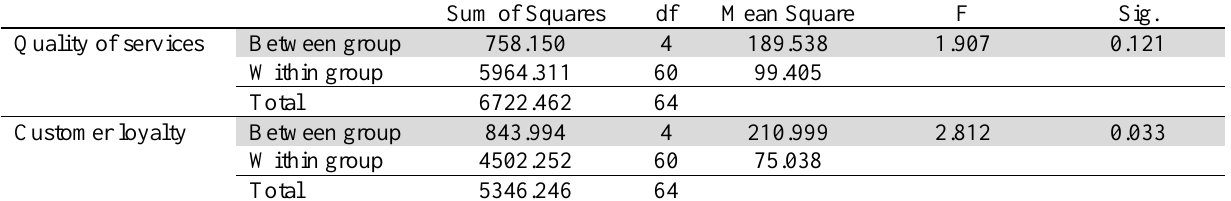
Sum of Squares Mean Square